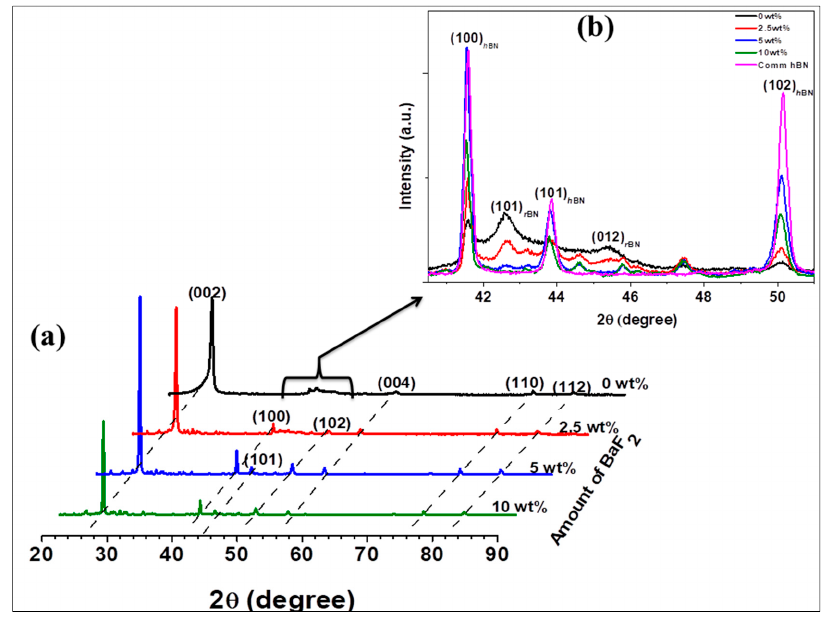
Figure 1. ( a ) and ( b ) XRD patterns for BNNS samples annealed at 1200 °C after the addition of 5 wt% Figure 1. ( a , b ) XRD patterns for BNNS samples annealed at 1200 ◦ C after the addition of 5 wt% Li 3 N Li 3 N together with 0–10 wt% of BaF 2 . together with 0–10 wt% of BaF 2